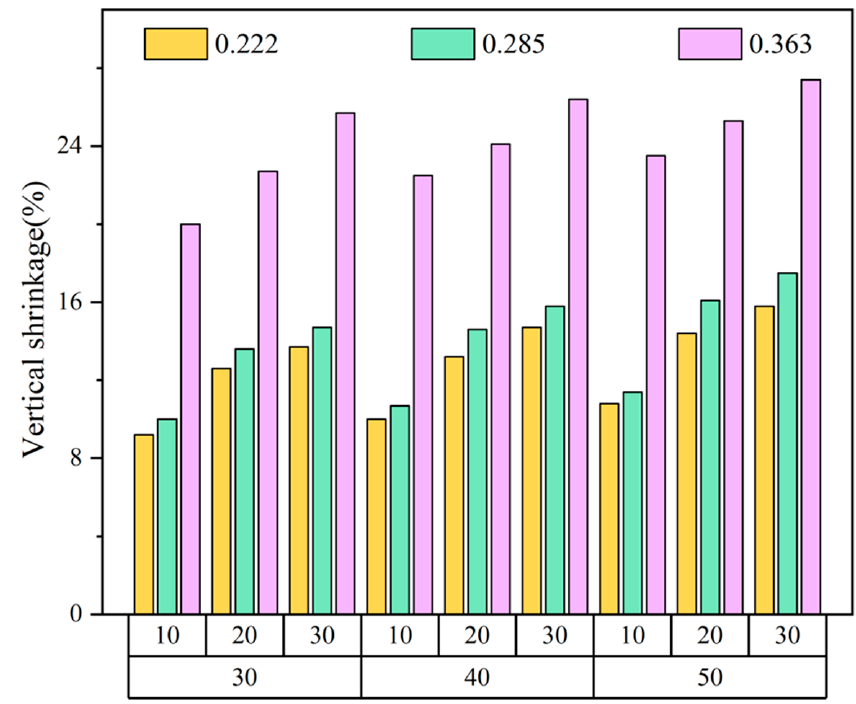
Figure 4. Change rate of sensors’ vertical size.